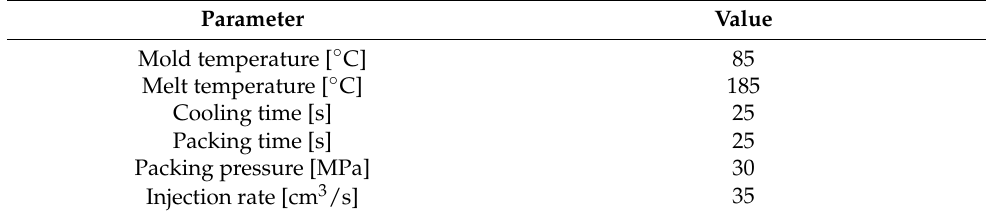
Figure 4. Numerical model of injection mold (FE of the tetra type). The injection molding processing parameters are presented in Table 3. Table 3. The injection molding processing parameters.